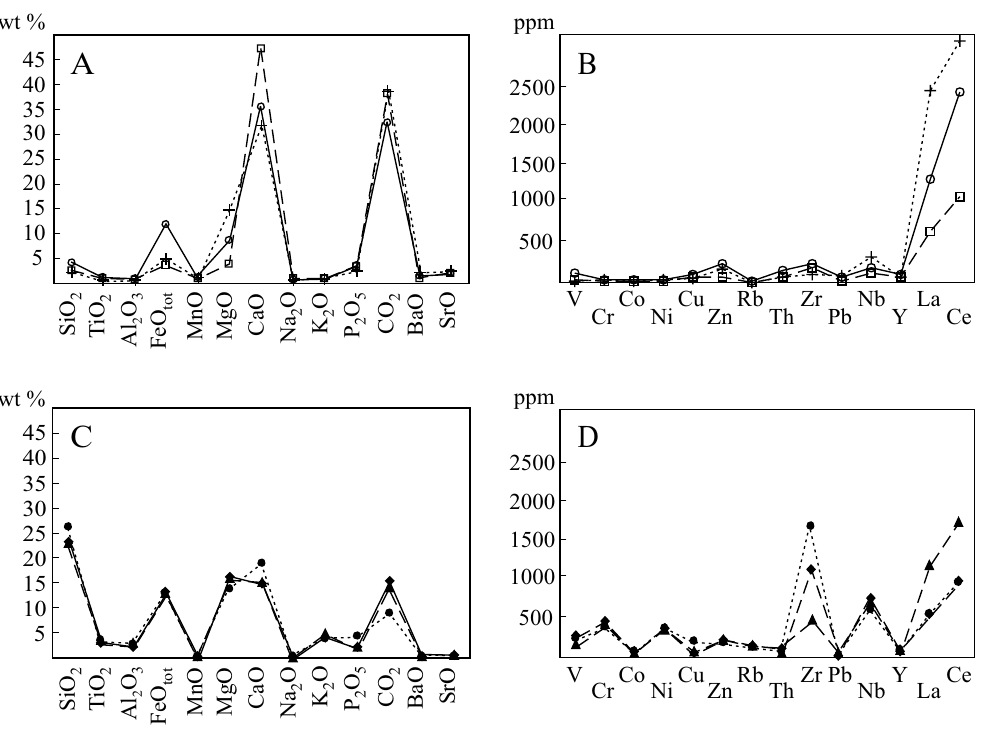
Fig. 6 – Average composition of carbonatites (A and B) and mica-rich rocks (C and D) from Araxá. Symbols: empty square, CaC; cross, MgC; empty circle, FeC; full diamond, G; full circle, MOP; full triangle,